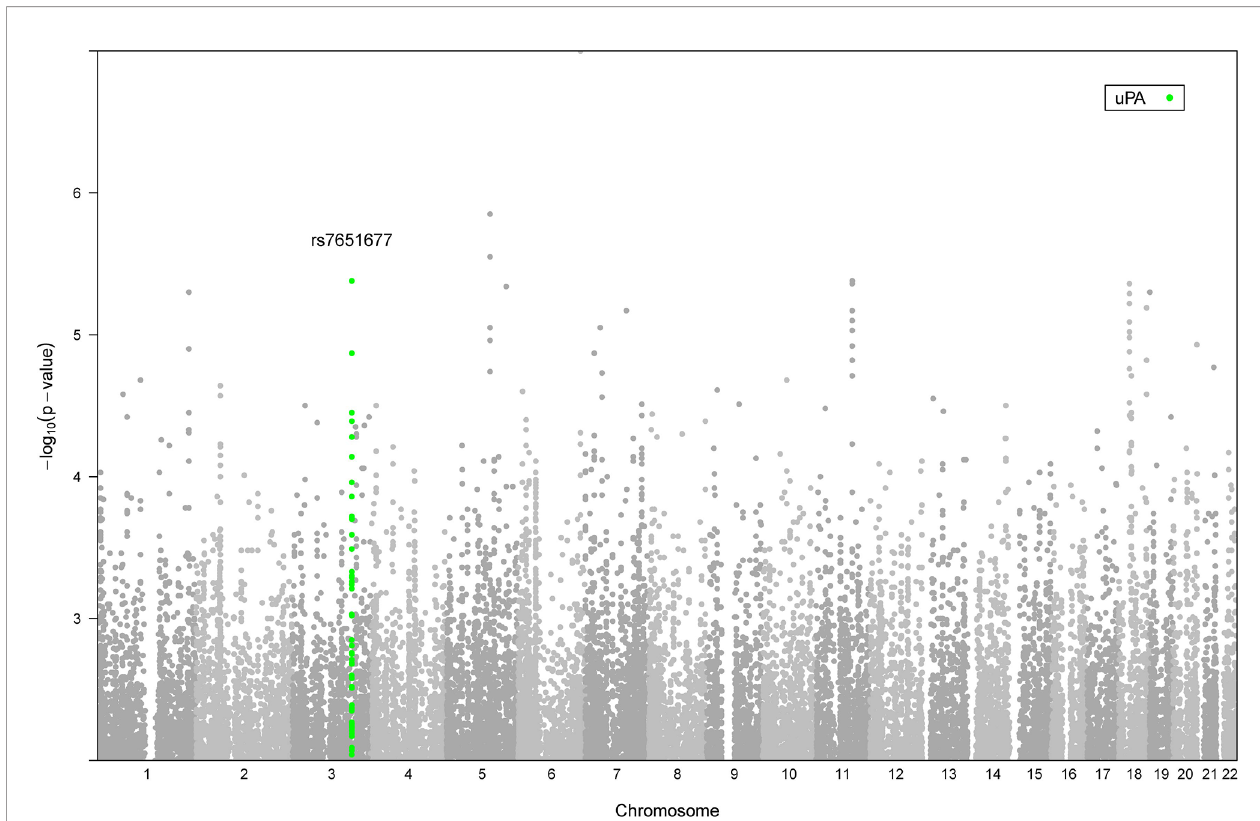
FIGURE 5 | Manhattan plot showing the genome-wide P values of association with survival. The y axis represents the negative log10 P values and their chromosomal positions are shown on the x axis. The locus marked at SNP rs7651677 on chromosome 3 that in fl uences uPA ( P 8.29 x 10 -6 , z score 4.46) and shows a strong association with survival ( P 3.52 x 10 -5 and OR 3) is highlighted with